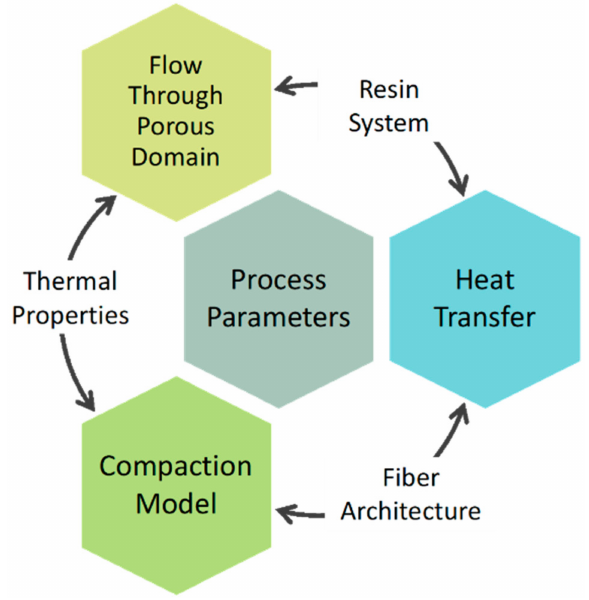
Figure 1. Governing physics of VBO process and integration with the prepreg material